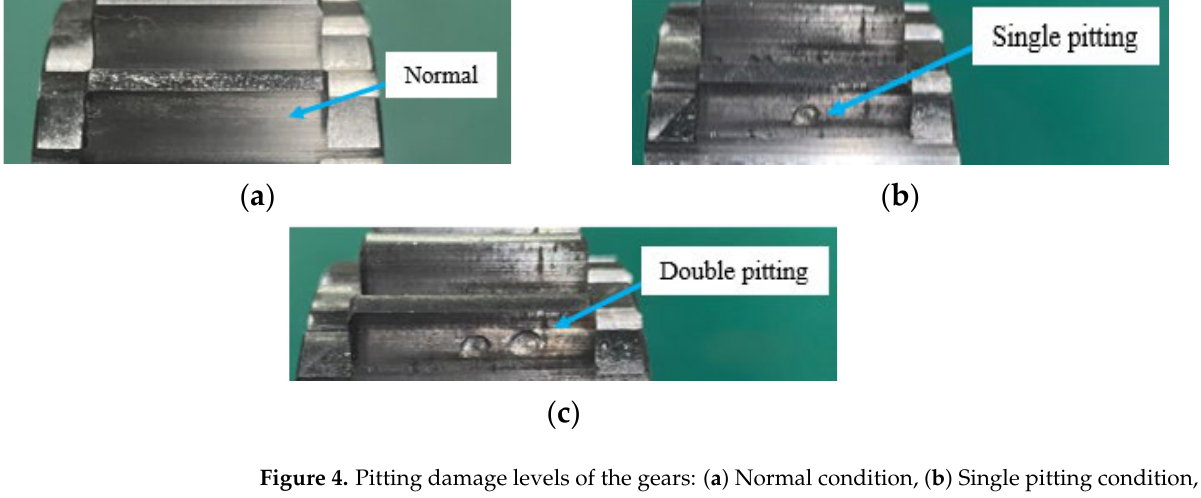
Figure 3. The pitting damage levels from normal to two: ( a ) Normal, ( b ) Single pitting, and ( c ) Double pitting.